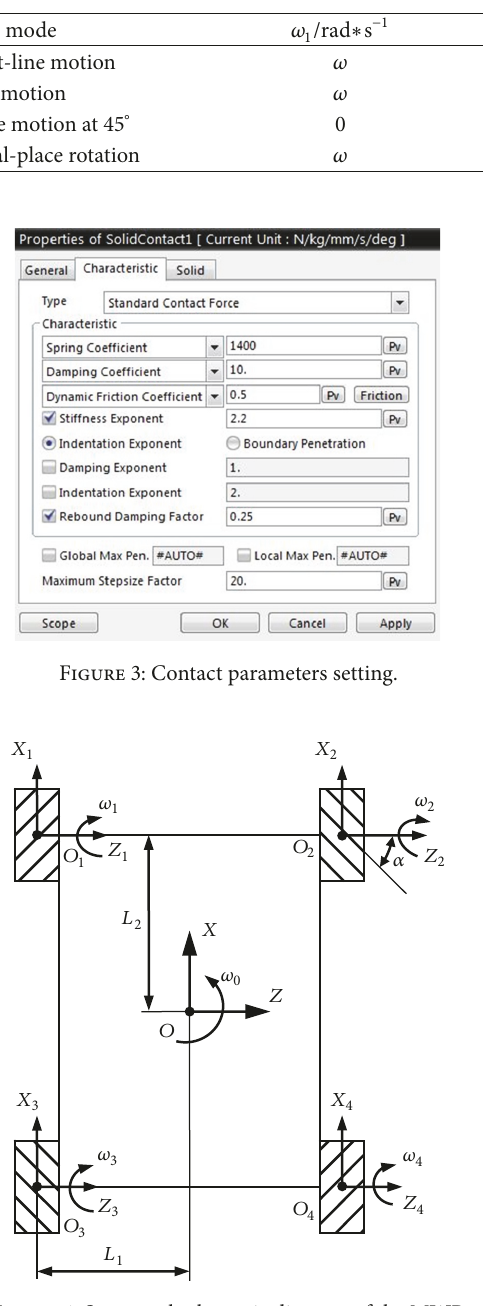
Table 1: Driving parameters setting of the platform in four typical motion states.